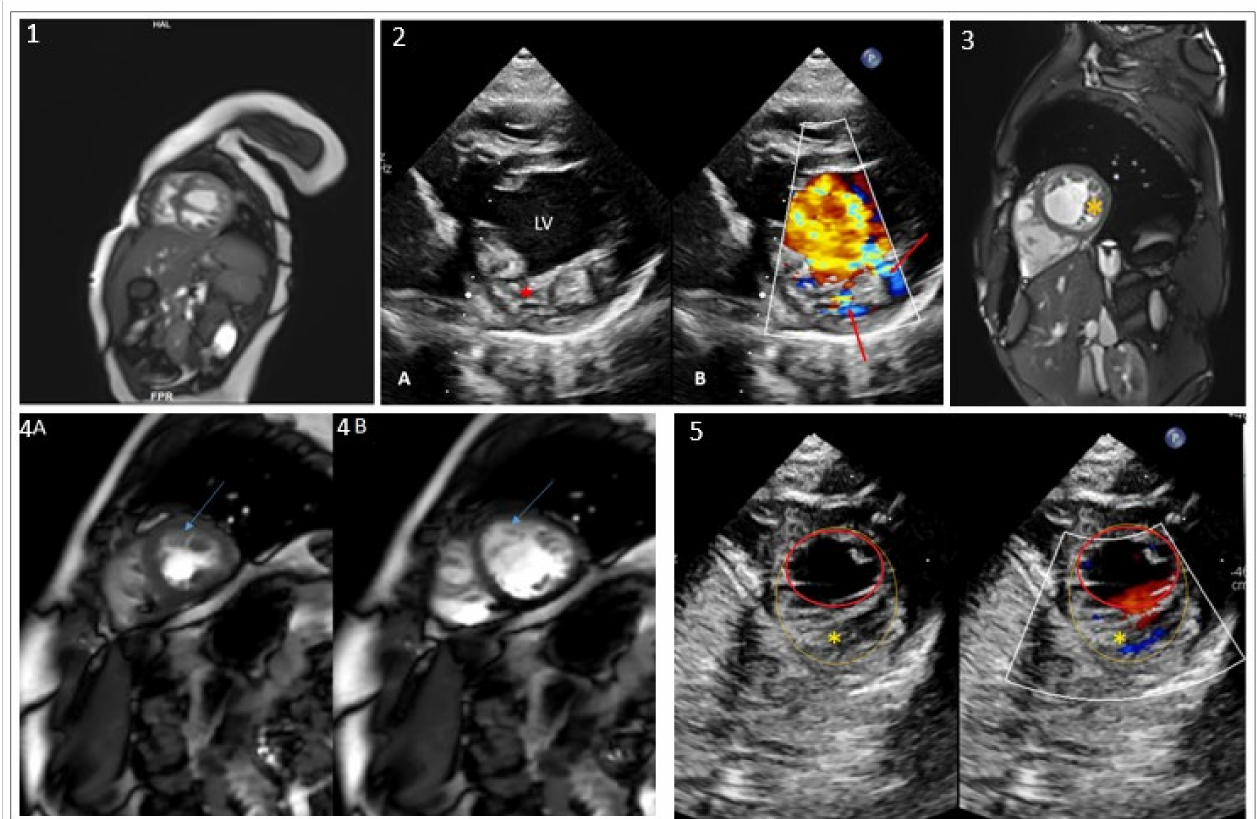
Figure 1. Echocardiograms, MRI images of the index patient and his relatives, family pedigree and variant conservation score. ( 1 ) MRI image of the index patient at the age of 8 months shows dilated-LVNC with altered LV function. ( 2 ) Transthoracic echocardiography of the index patient: ( 2A ) Parasternal short axis view showing the left ventricle (LV) with increased trabeculations (red asterisk). ( 2B ) Color Doppler analysis, the red arrows show the blood flow in the intratrabecular recesses. ( 3 ) MRI image of the index patient’s father showing LVNC (yellow asterisk) (subject I-1). ( 4 ) MRI images of subject II-1 showing LV short axis in systolic ( 4A ) and diastolic ( 4B ) phases with LVNC (blue arrow). ( 5 ) Echocardiography of subject II-3 showing trabeculated LV (yellow asterisk). An endocardial border (red circle) and non-compacted layer border to include the trabeculated area (yellow circle) are